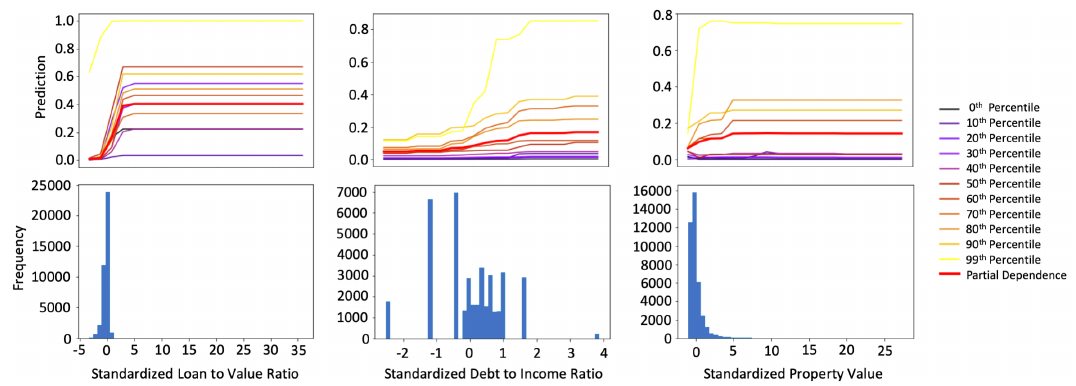
Figure 3. PD, ICE for ten individuals across selected percentiles of g MGBM ( X ) , and histograms for the three most important input features of g MGBM on the mortgage test data.